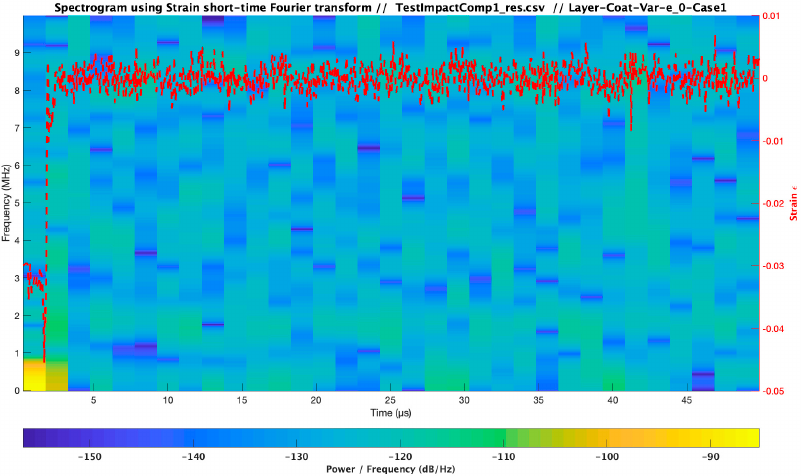
Figure 18. Spectrogram for strain evolution at the coating surface for the Reference multilayer configuration. Material models analysis for Pure elastic consideration.